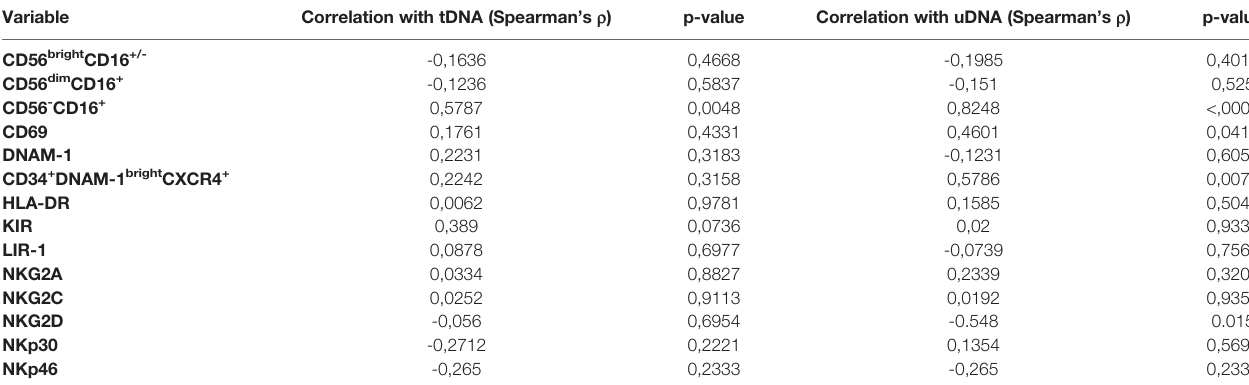
TABLE 2 | Correlation analysis of Natural Killer cell subsets with total and unintegrated HIV HNA (tDNA and uDNA). Variable Correlation with tDNA (Spearman ’ s r ) p-value Correlation with uDNA (Spearman ’ s r ) p-value CD56 bright CD16